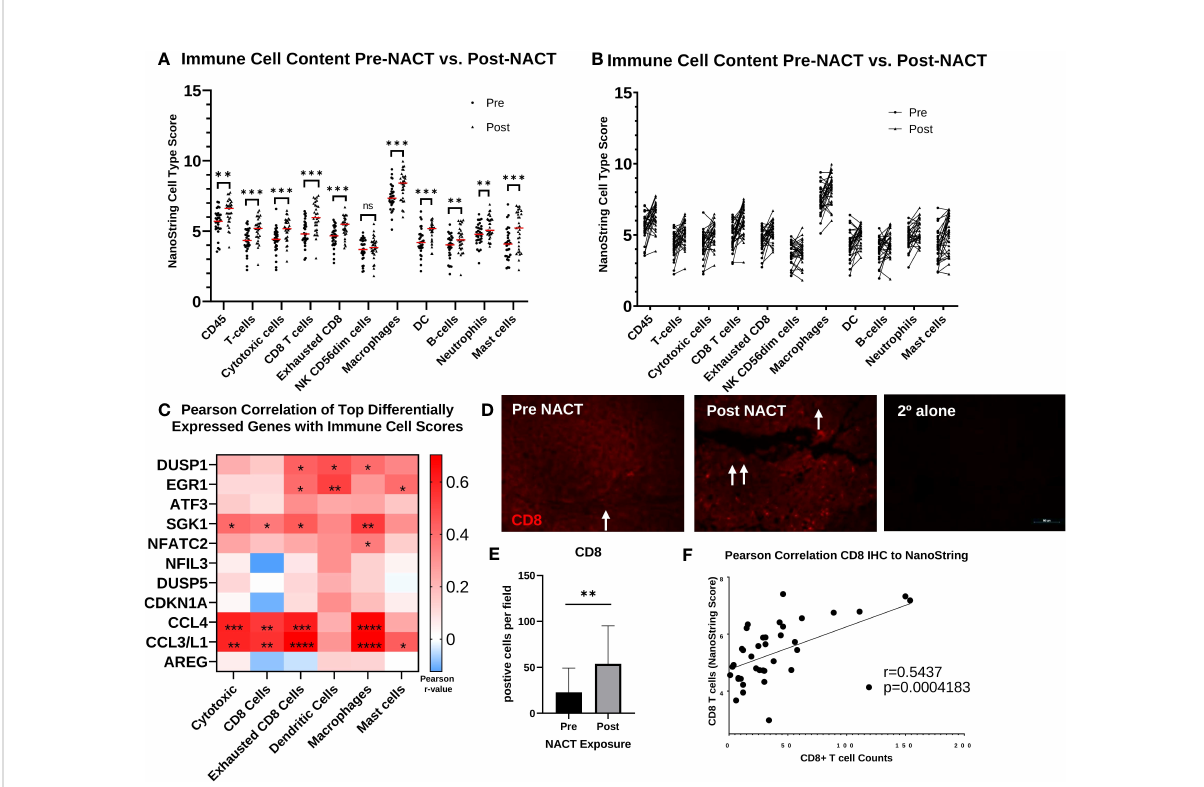
FIGURE 7 Immune cell in fi ltration increases post-NACT. (A) NanoString immune cell score changes pre- and post-NACT. Red line illustrates median. Scores do not indicate abundance of one cell type relative to another. Signi fi cance determined using 2-tailed Wilcoxon matched-pairs signed rank test. **p<0.005; ***p<0.0005; ns, not signi fi cant. DC, dendritic cells. (B) Individual patient changes of immune cell populations. (C) Pearson correlation of top differentially expressed genes post- vs. pre- NACT with immune cell population scores. *p<0.05; **p<0.005; ***p<0.0005; ****p<5e-5. (D) Representative image of IHC showing CD8+ T cells pre- and post-NACT. CD8 = red; DAPI (nuclear) = blue. Arrows indicate CD8+ cells. 2° alone = secondary antibody control. (E) Quanti fi cation of CD8+ T cell numbers pre- and post-NACT. Signi fi cance was